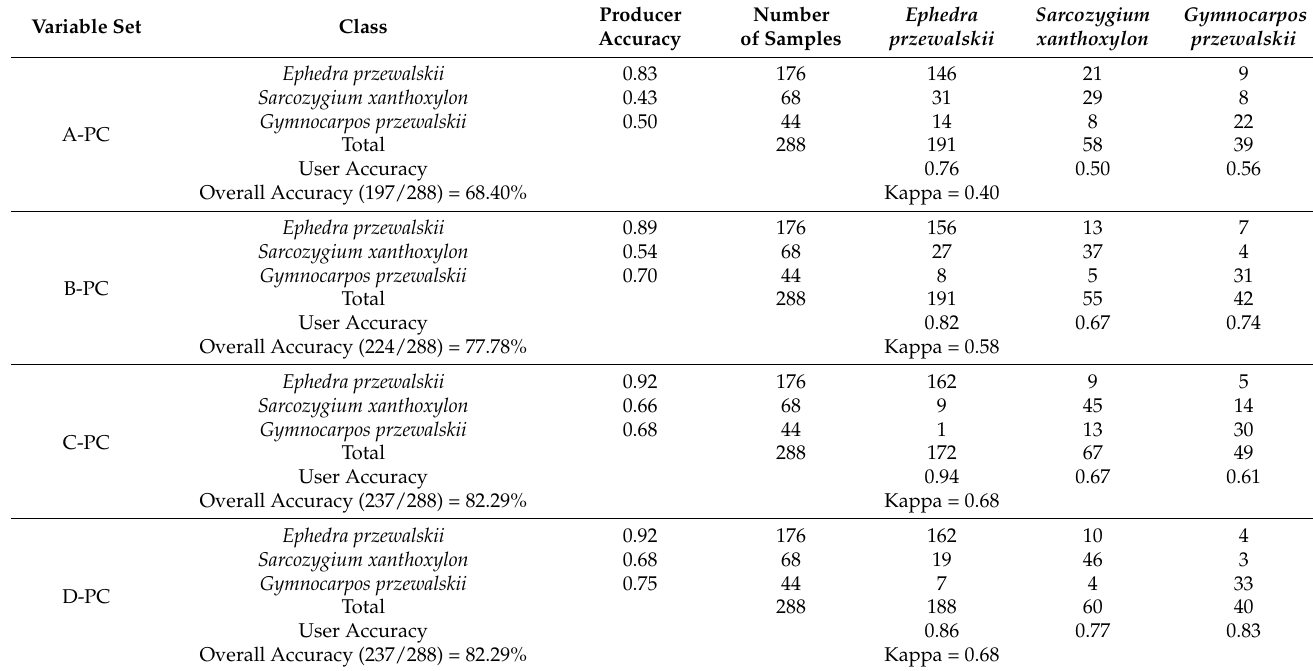
Table A5. Comparison of classification accuracies of individual shrub species maps from EPPR–SAXA–GYPR alliance of four sets of variables generated by the random forest (RF)